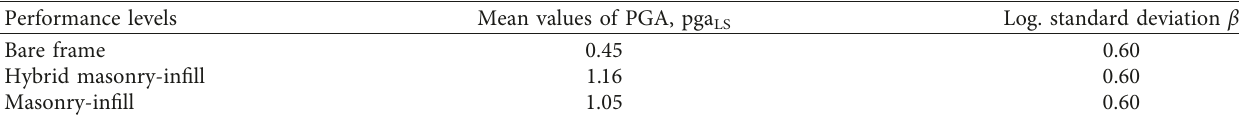
Table 5: PGA LS derived for roof drift of 0.30%.